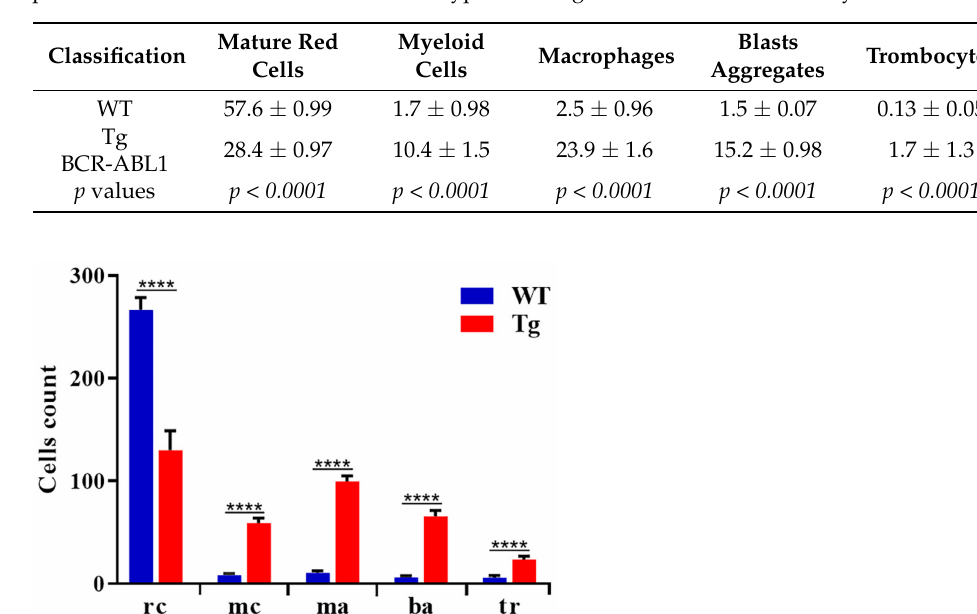
Figure 6. Cytological analysis of transgenic fish expressing hBCR-ABL1. May-Grunwald-Giemsa staining of peripheral blood cells from wild type ( A ) and Tg BCR-ABL1. Samples are representative of 15 wild type and Tg BCR-ABL1 fish 15 months old. Different types of cells are indicated in the pictures in ( C – G ). Table 2. Different cell types in zebrafish peripheral blood. Myeloid cells include eosinophil and neutrophil granulocytes eosinophilic. The measurement is expressed in percentage. The counts were performed on 500 cells/field and 15 wild type and 15 tg BCR-ABL1 fish were analyzed.